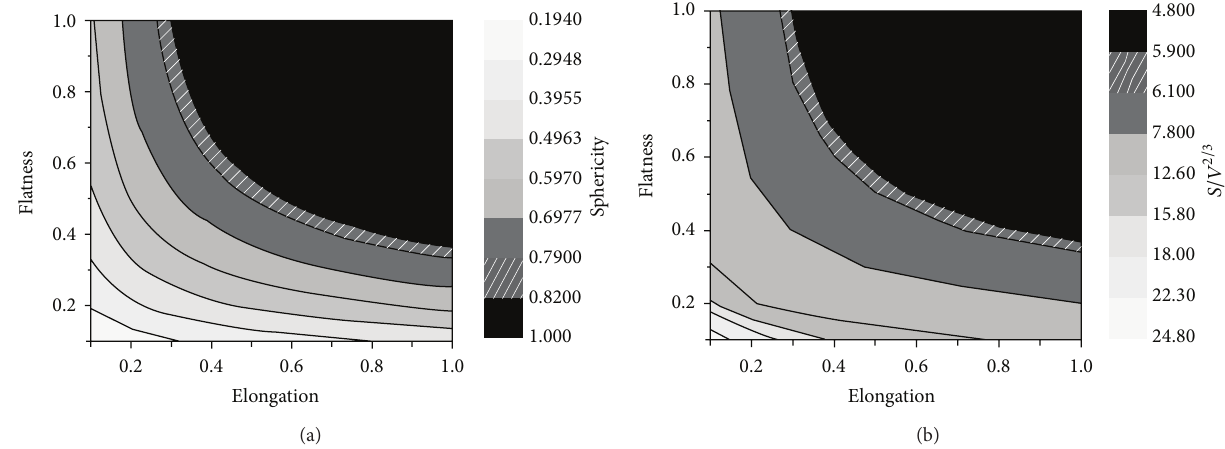
Figure 4: Distribution contours of (a) sphericity and (b) 𝑆/𝑉 2/3 with different elongation and flatness of an ellipsoid.